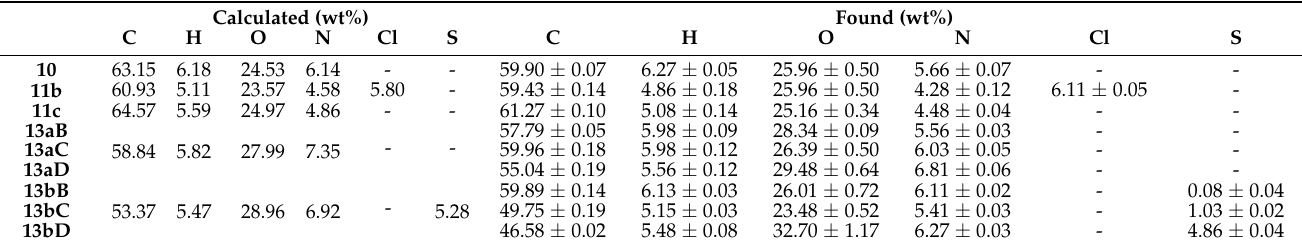
Table 1. Results of elemental